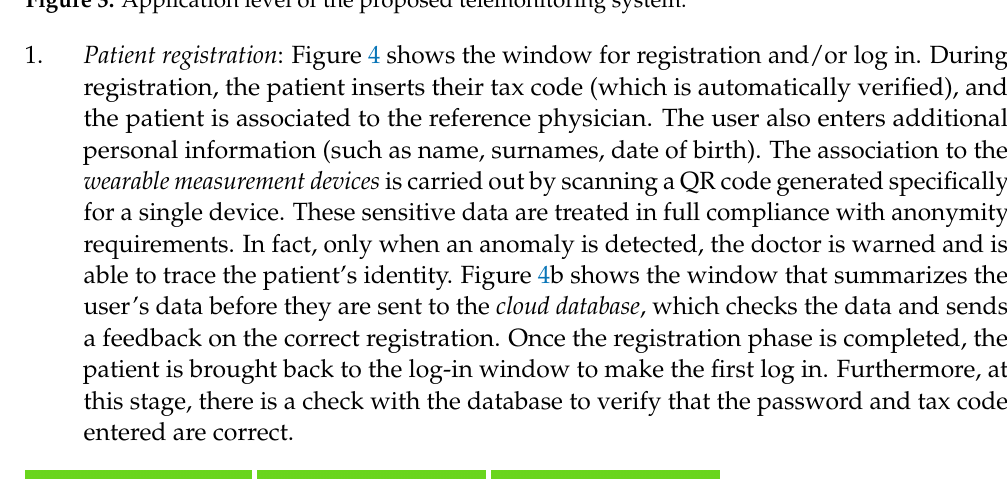
Figure 3. Application level of the proposed telemonitoring system.